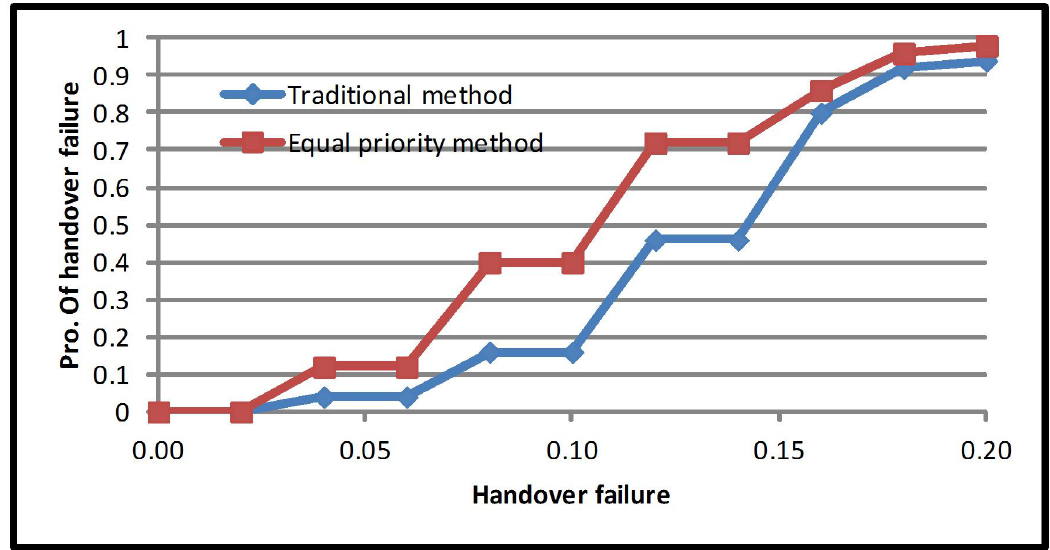
Figure 5. Average handover failure probability of the equal priority